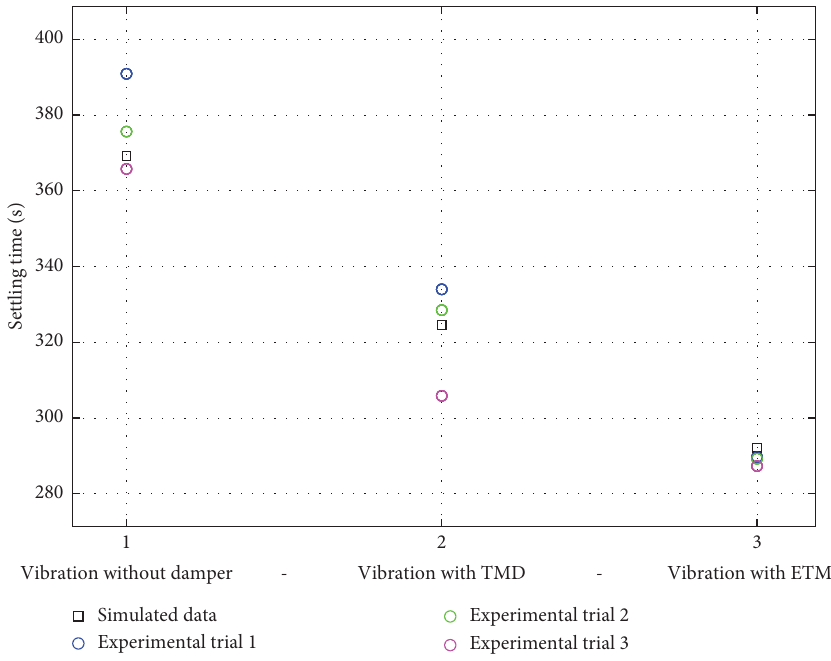
Figure 15: Comparison between settling times in cases without damper, with AMS and with